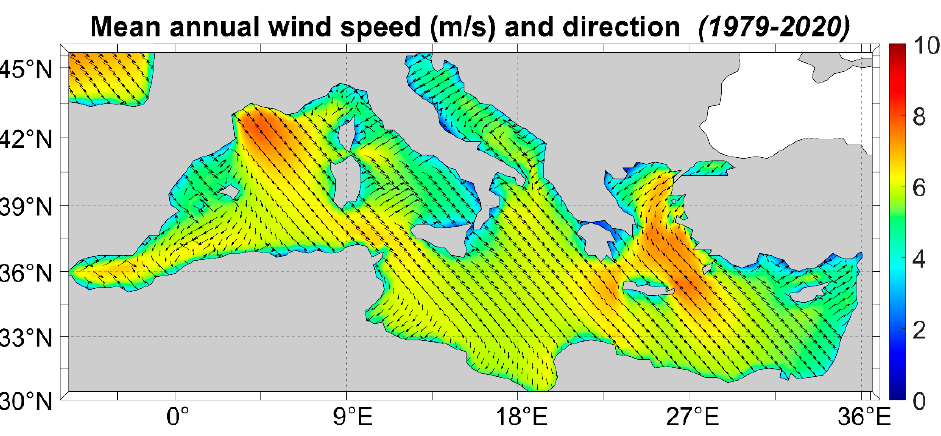
Figure 2. Mean annual wind speed and direction.